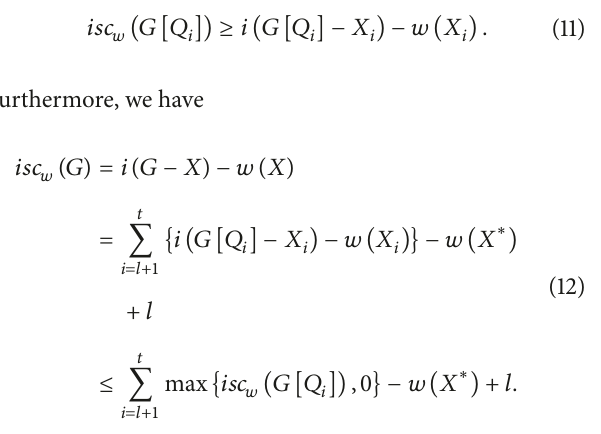
Algorithm 1 for computing all local cuts of an interval